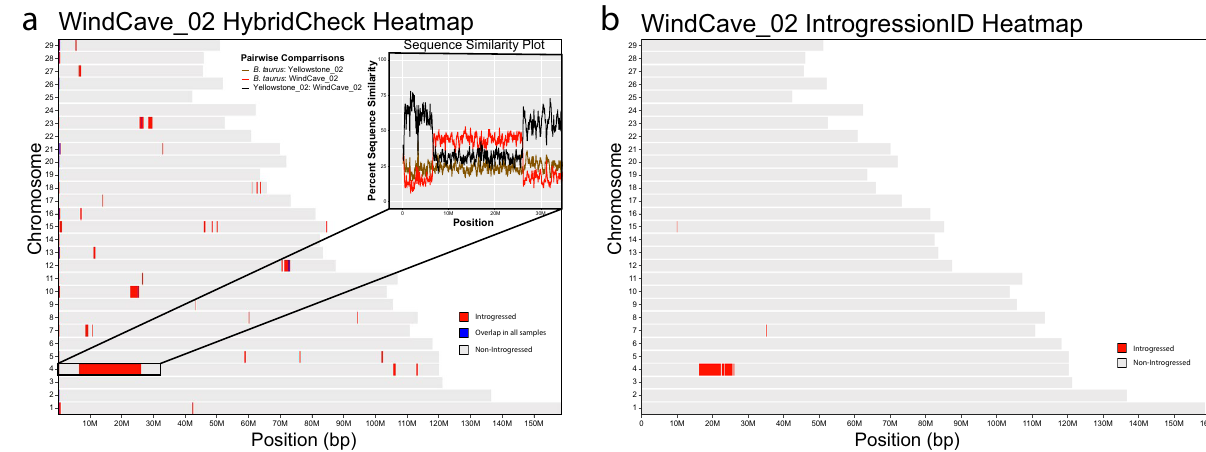
Figure 5. Whole genome heatmap of detected introgressed blocks by HybridCheck ( a ) and IntrogressionID ( b ) for individual WindCave_02. Chromosomes are listed numerically along the y-axis and their lengths are represented by the length of the respective heatmap box along the x-axis. Across each chromosome, the grey coloration indicates regions of no signal for introgression, the red coloration indicates signal of introgression and the blue coloration in ( a ) indicates signals of introgression that overlap across all sample comparisons for HybridCheck. The zoomed in box shows the HybridCheck output data plotted in a line graph with percent sequence similarity across the y-axis and base pair position across the